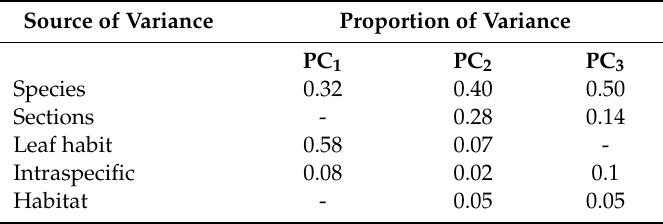
Table 3. Variance partitioning of the first three principal components (PC). Variance partitioning for each PC among components expressing variation between species (Species), leaf habits (Leaf habit), sections (Sections), plots (Habitat) and species